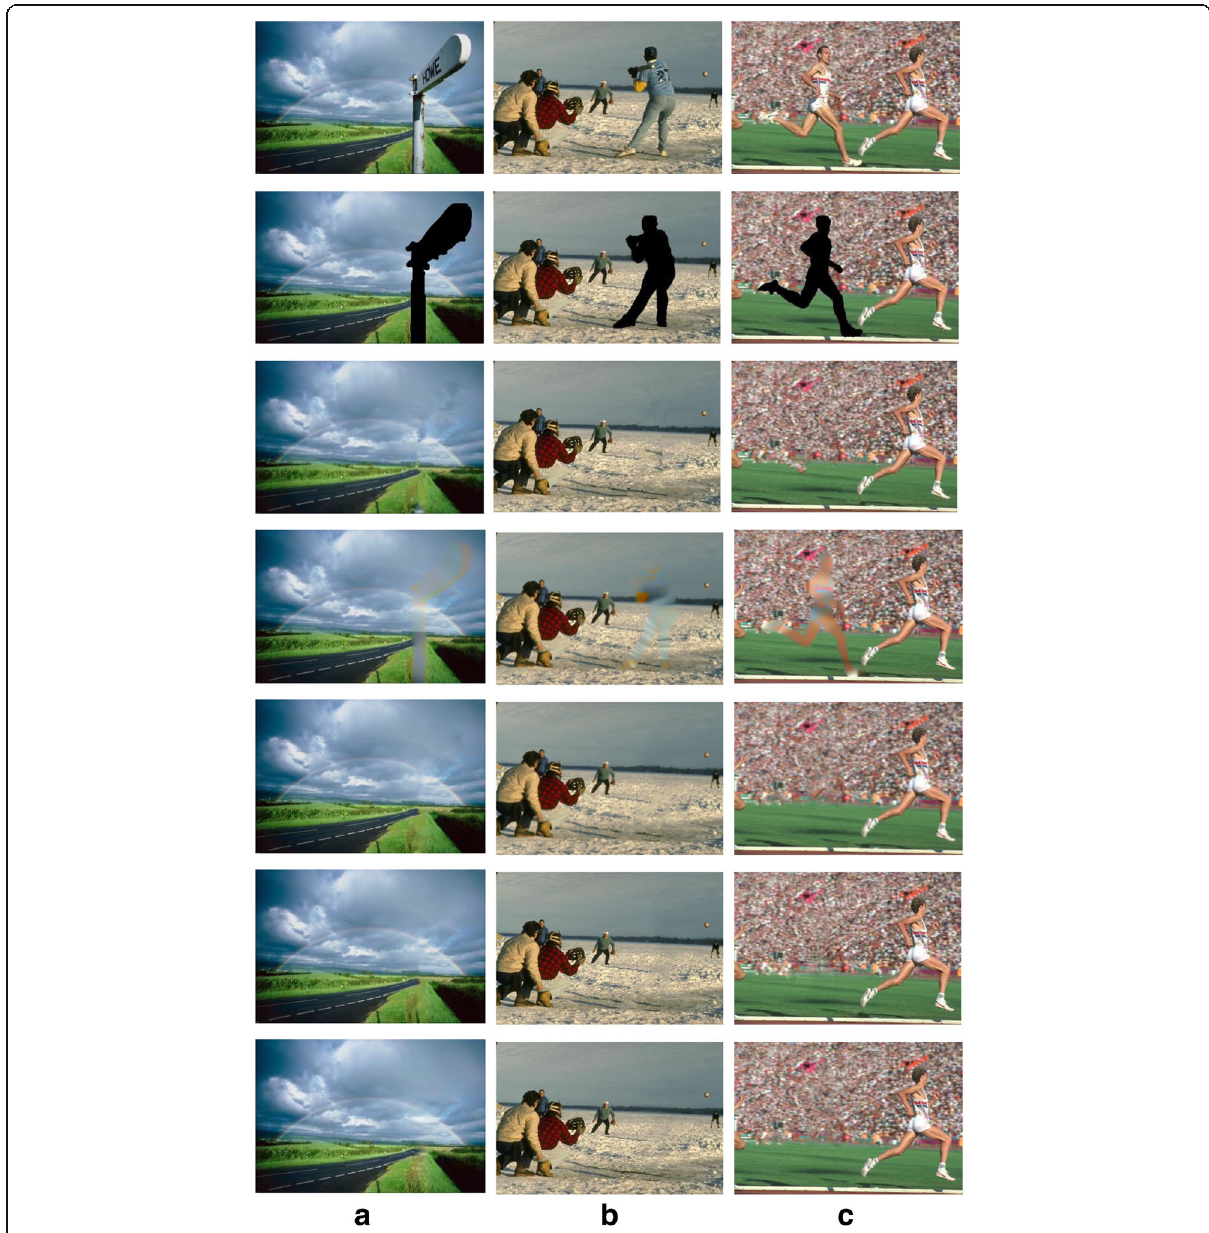
Fig. 10 The restore results of object removal task. Row 1, Original images. Row 2 , Masked images. Row 3 , Criminisi ’ s method [10]. Row 4, GSR method [29]. Row 5 , Image melding method [28]. Row 6, ALOHA method [30]. Row 7, Proposed